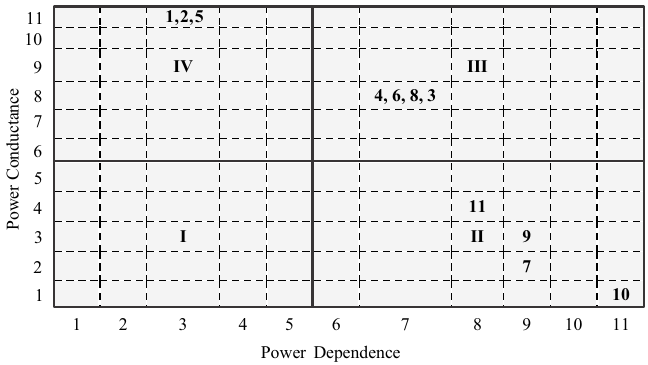
Fig. 3. Diagram of leading power and